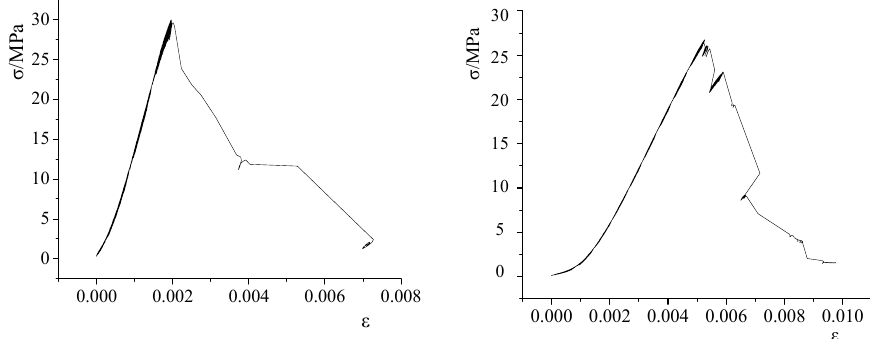
Figure 5. Stress–strain curves of sandstone specimens under uniaxial compression.